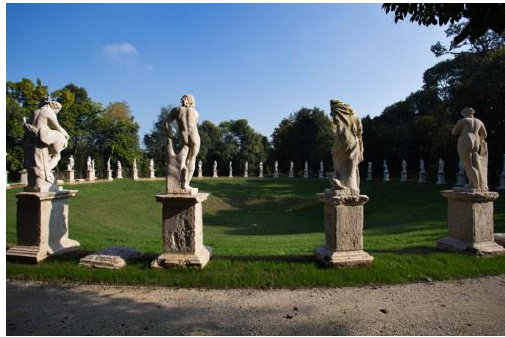
Figure 6: View of the arena-cavallerizza